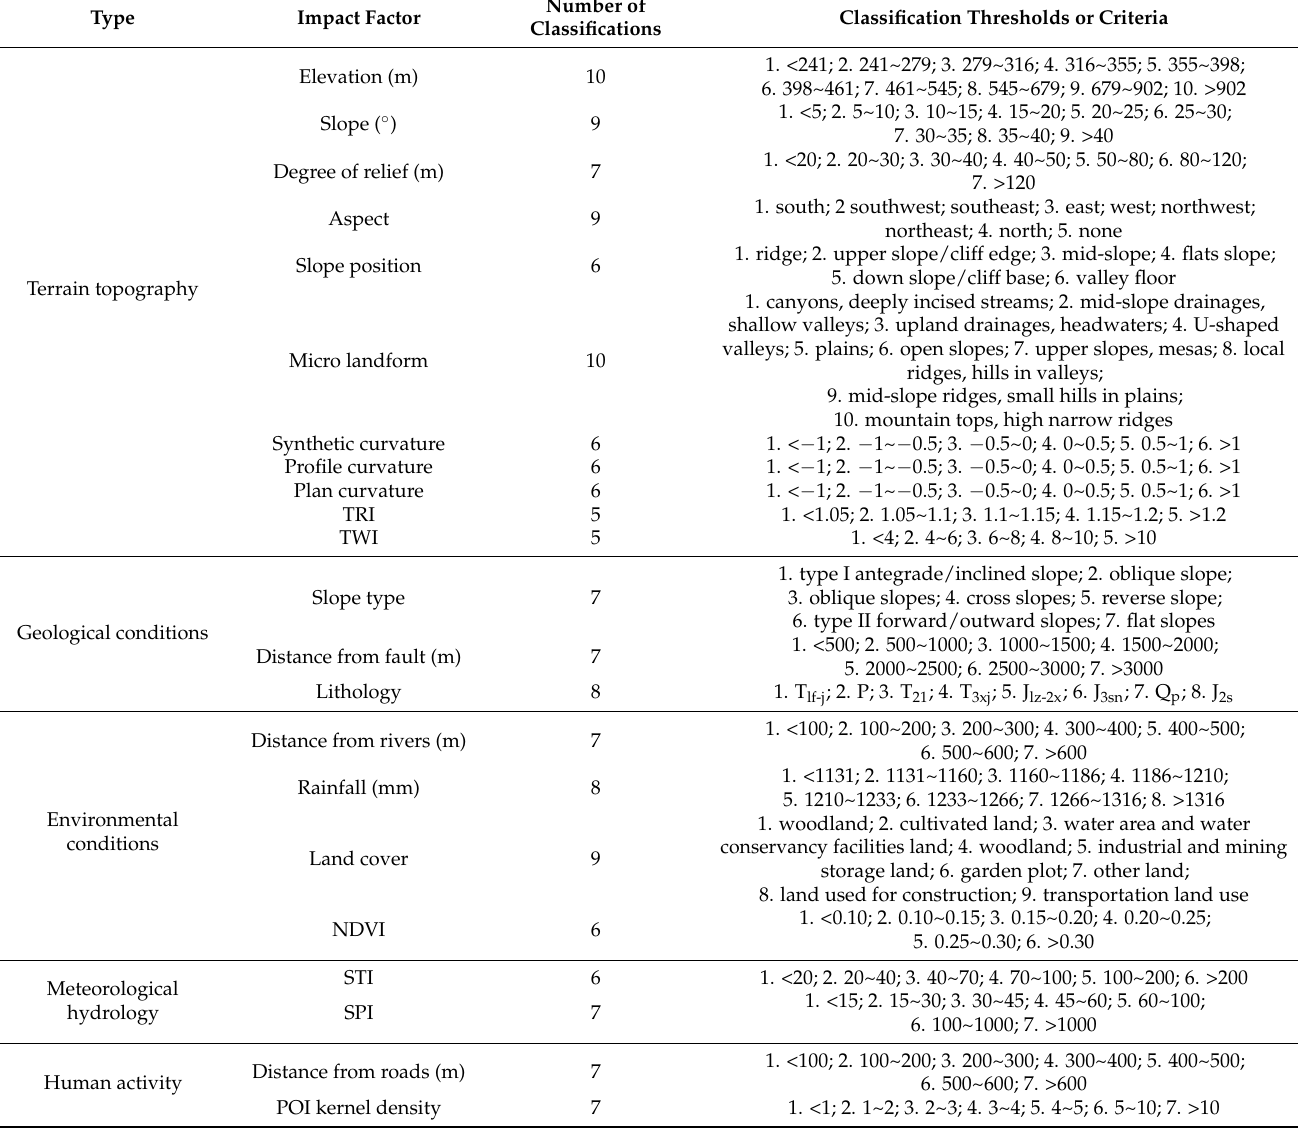
Table 2. Classification of factors influencing landslide